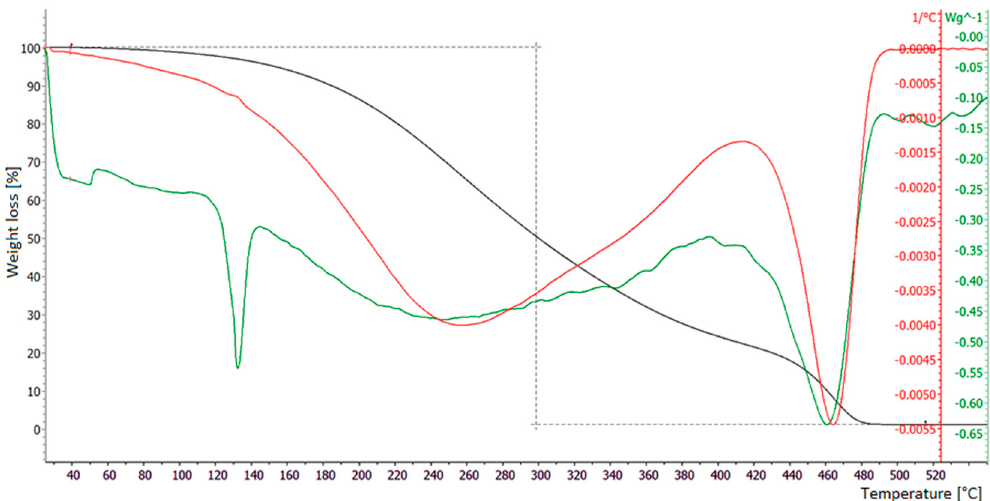
Figure 6. TG analysis of a PP sample. Black line: TGA (weight loss); red line: first derivative of the TGA; green line: DSC (differential scanning calorimetry).